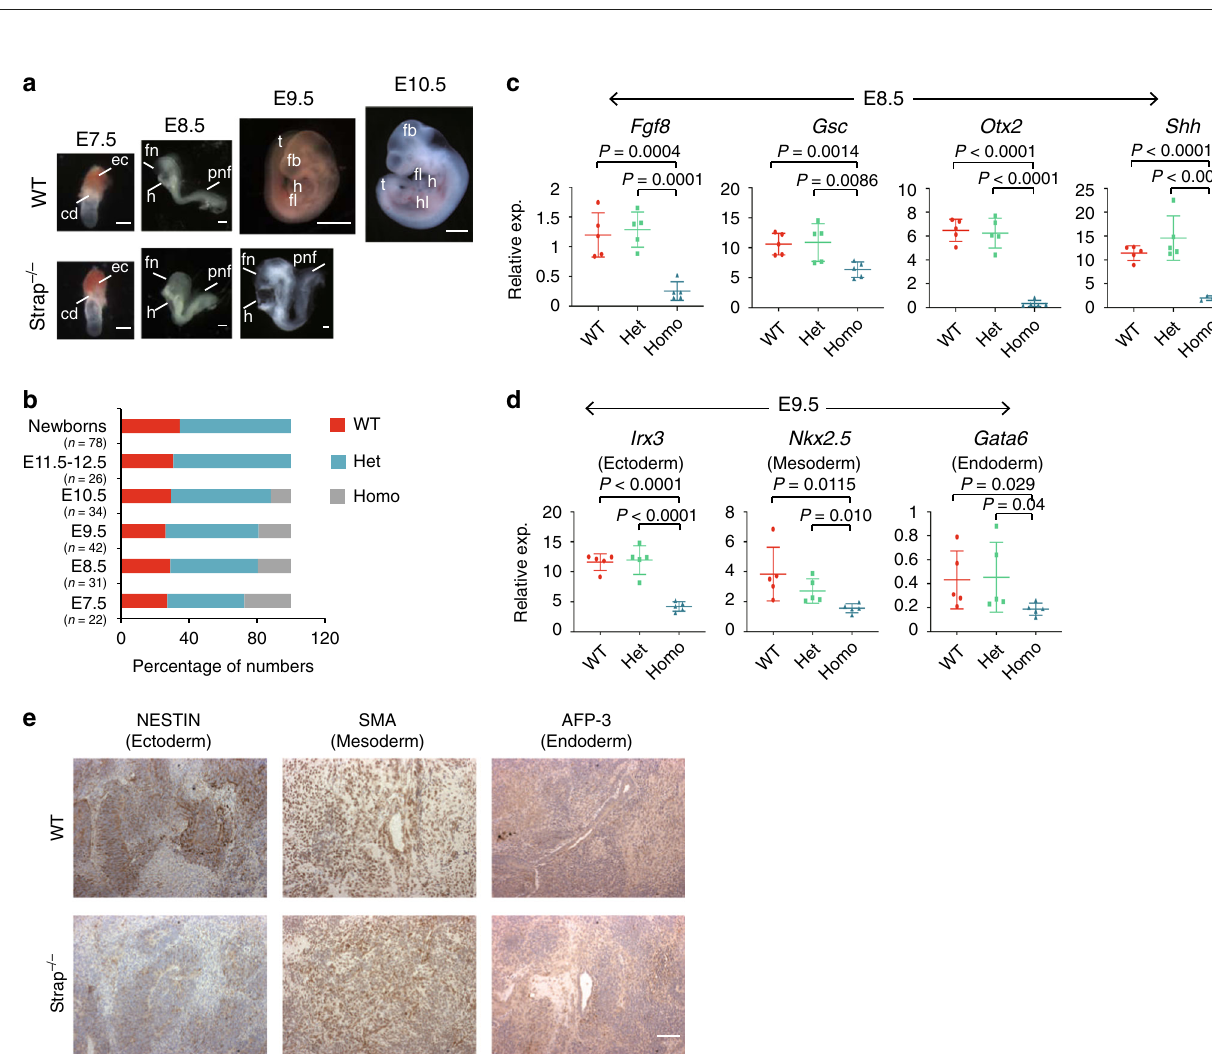
Fig. 1 Mouse embryo early organogenesis is associated with transcript isoform diversity. a Schematic display of fi ve AS types. SE, skipped exon; MXE, mutually exclusive spliced exon; A5 ′ SS/A3 ′ SS, alternative 5 ′ /3 ′ splicing site; RI, retained intron. b Violin plots representing distributions of statistically signi fi cant Δ PSI (percent spliced-in) values ( Δ PSI = PSI(E9.0) – PSI(E8.0); | Δ PSI|> 0.1, FDR < 0.05) for different classes of AS events. Kernel density is shown as a symmetric curve. The lower and upper bounds of the embedded box represent the 25th and 75th percentile of the distribution, respectively. The horizontal line in the box represents the median. The lower and upper whiskers show minima and maxima, respectively. The numbers of events are shown below each plot. c Volcano plot showing the difference of AS events between E8.0 and E9.0 mouse embryos. Δ PSI is plotted against the – log fi cance (| 10 (FDR) value. The color points outside the two dashed gray lines in the plot represent the differentially expressed AS with statistical signi = 20 are indicated. d GO analysis of alternatively spliced genes between E9.0 and E8.0 mouse embryos, Δ PSI|> 0.1, FDR < 0.05). Genes with – log 10 (FDR) > showing the top fi ve to six ranked terms. e Validation by RT-PCR for genes with SE events identi fi ed by rMATS. PSI values are shown below the gel pictures. The information of target exons is shown on the right panel. Empty box, constitutive exon; black box, skipped exon. The experiment was repeated three independent times with similar results. Gapdh was used as a loading control.